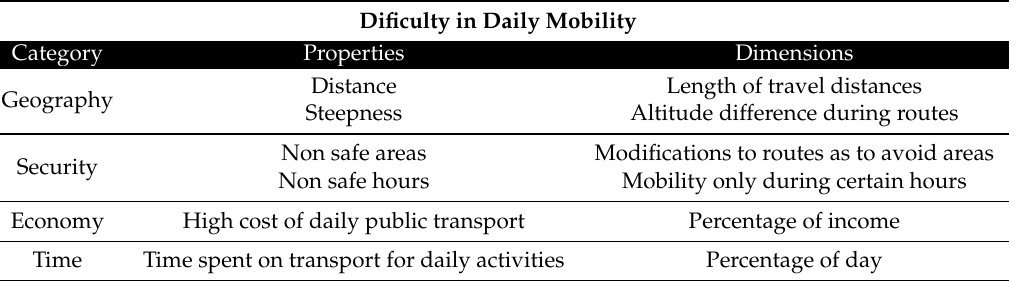
Table 5. Axial coding of interviews about